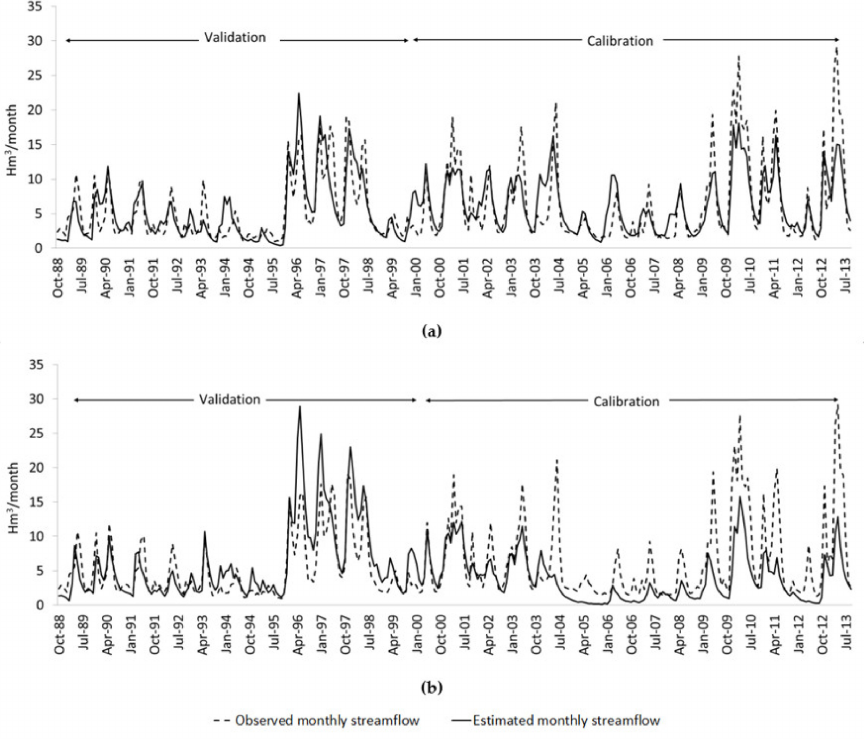
Figure 10. Estimated monthly streamflow for the period October 1988–September 2013 with the preliminary climatic fields and the corrected ones: ( a ) RK model; ( b ) linear KED